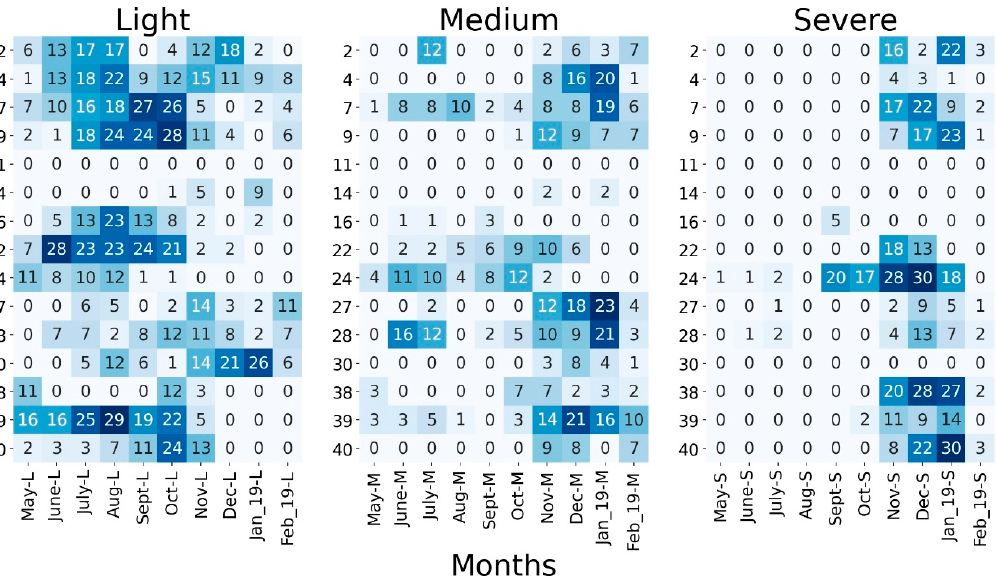
Figure 11. Boxplots of internal temperatures, where the light grey ( fi rst from left to right) corre- sponds to the temperatures monitored with sensors. The blue boxes (second from left to right) cor- respond to the simulations with double glazing, the green (third from left to right) to the homes only with insulation, and the white (fourth from left to right) correspond to the ones under the NOM-ENER-021 parameters.